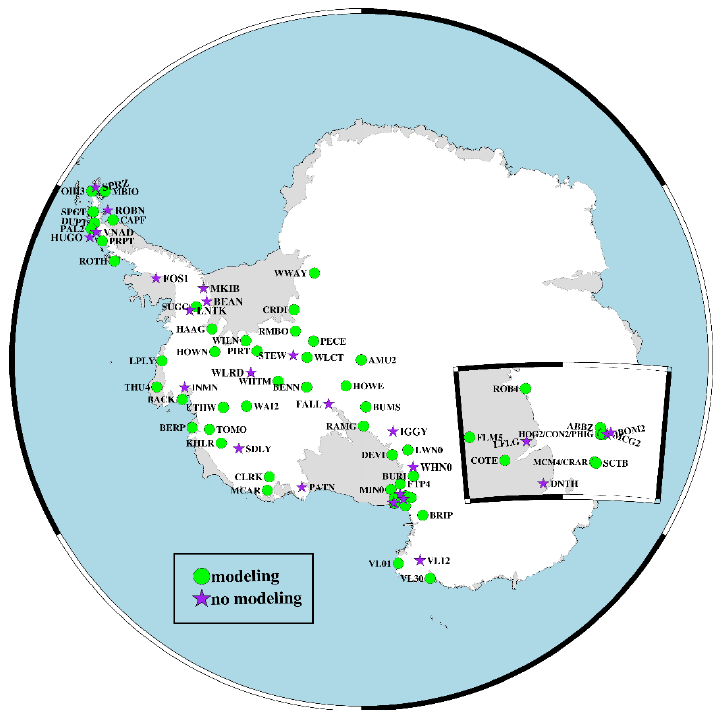
Figure 3. Distribution of modeling and nonmodeling stations in West Antarctica.